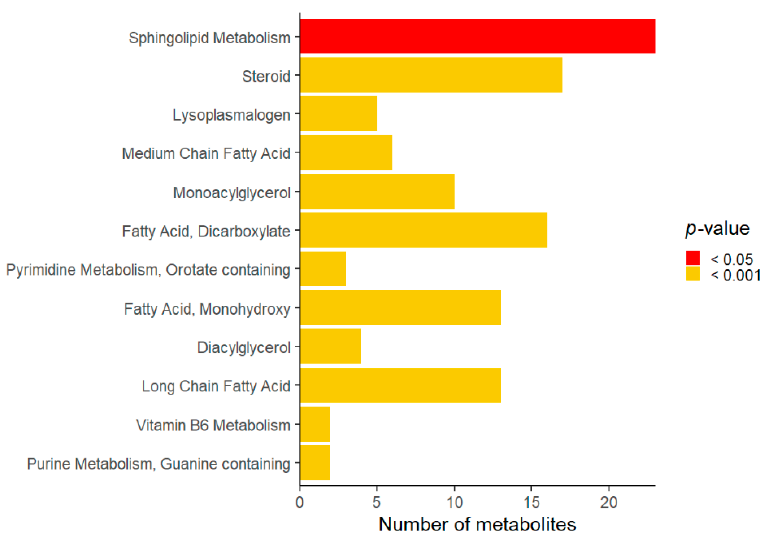
ff ected in Rett